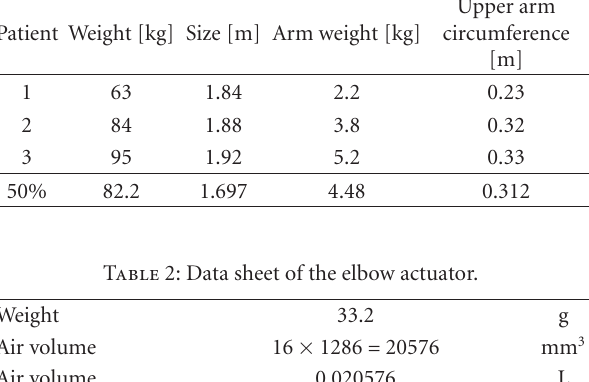
Table 1: Data of the three subjects.